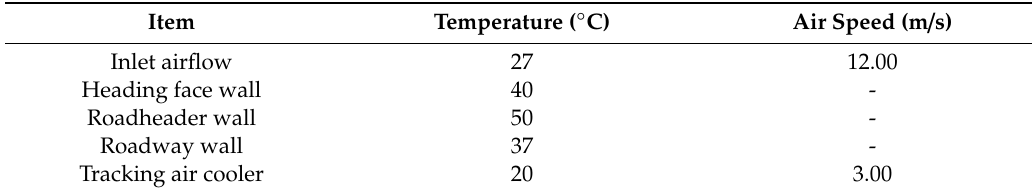
Table 1. Boundary conditions for numerical